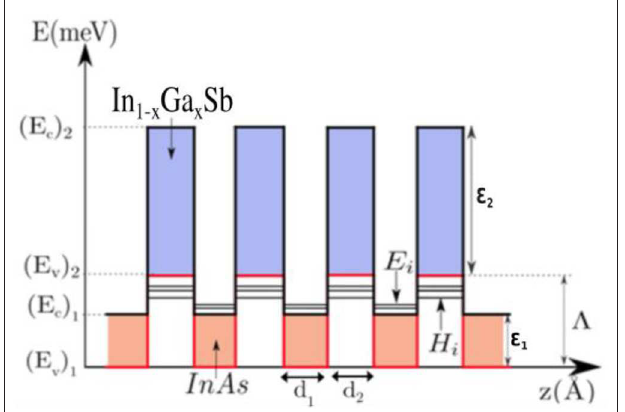
Ga x Sb SL along the growth − x 1 and 2 are conduction and valence band = is the valence band = ∧